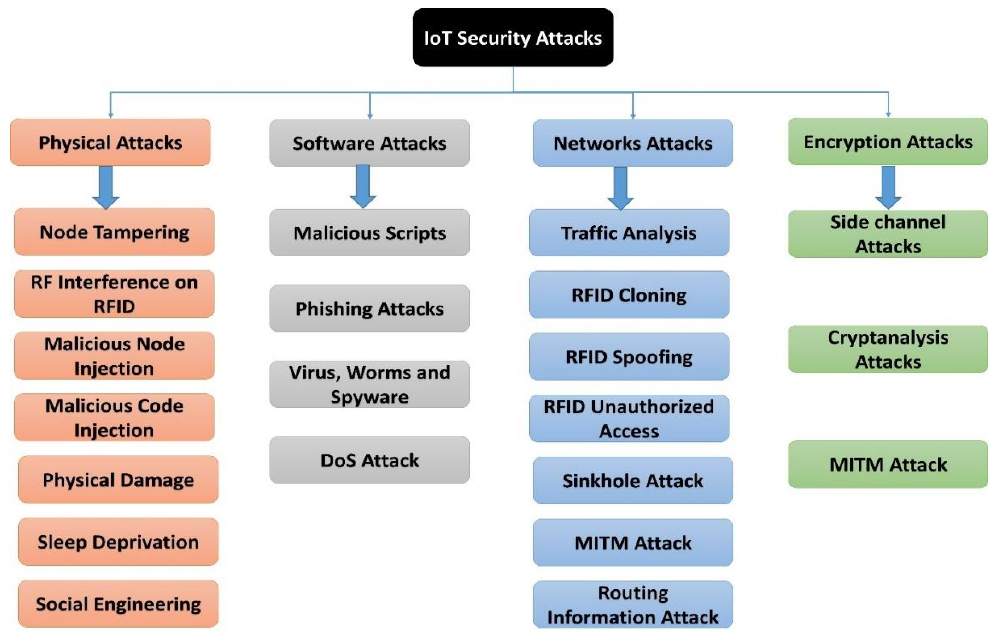
Figure 1. Main types of cyber-attacks against the different layers of IoT systems.